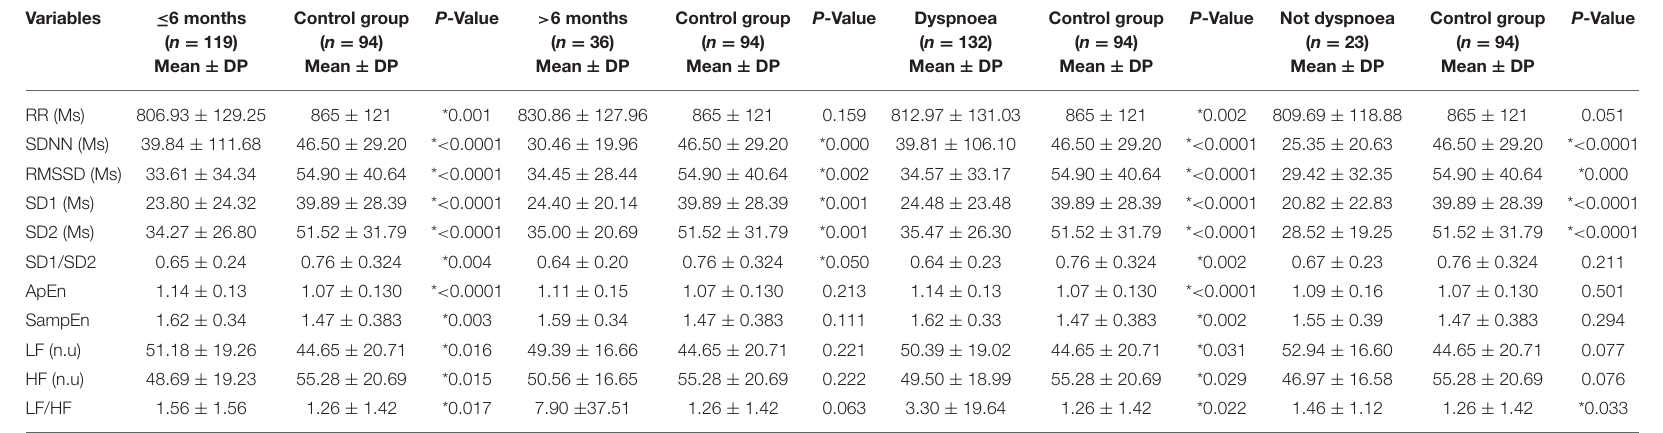
TABLE 5 | Analysis of HRV considering the duration of long COVID-19 and dyspnoea in the control group.